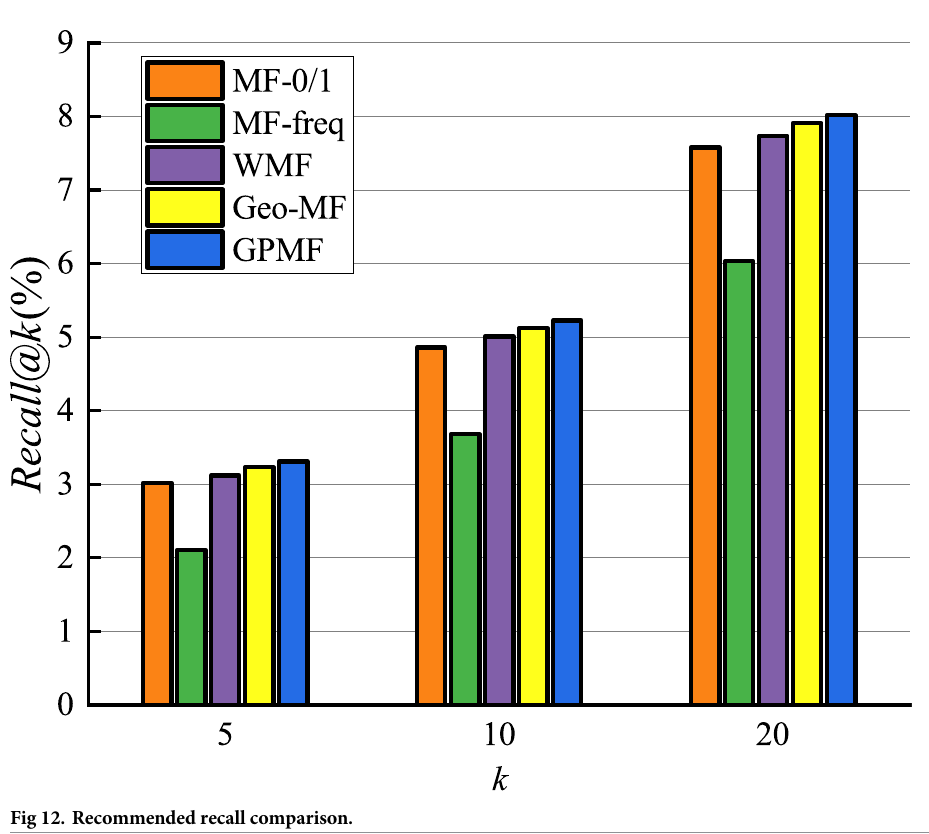
Fig 12. Recommended recall